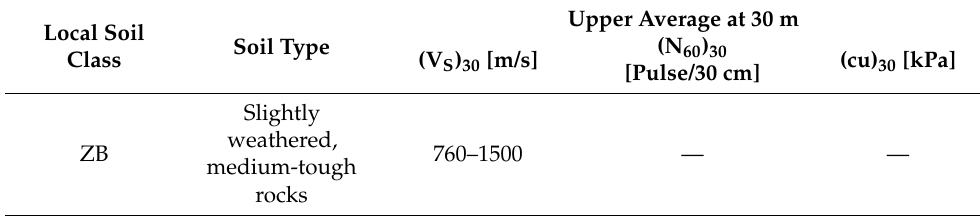
Table 4. Local soil class type ZB [17].